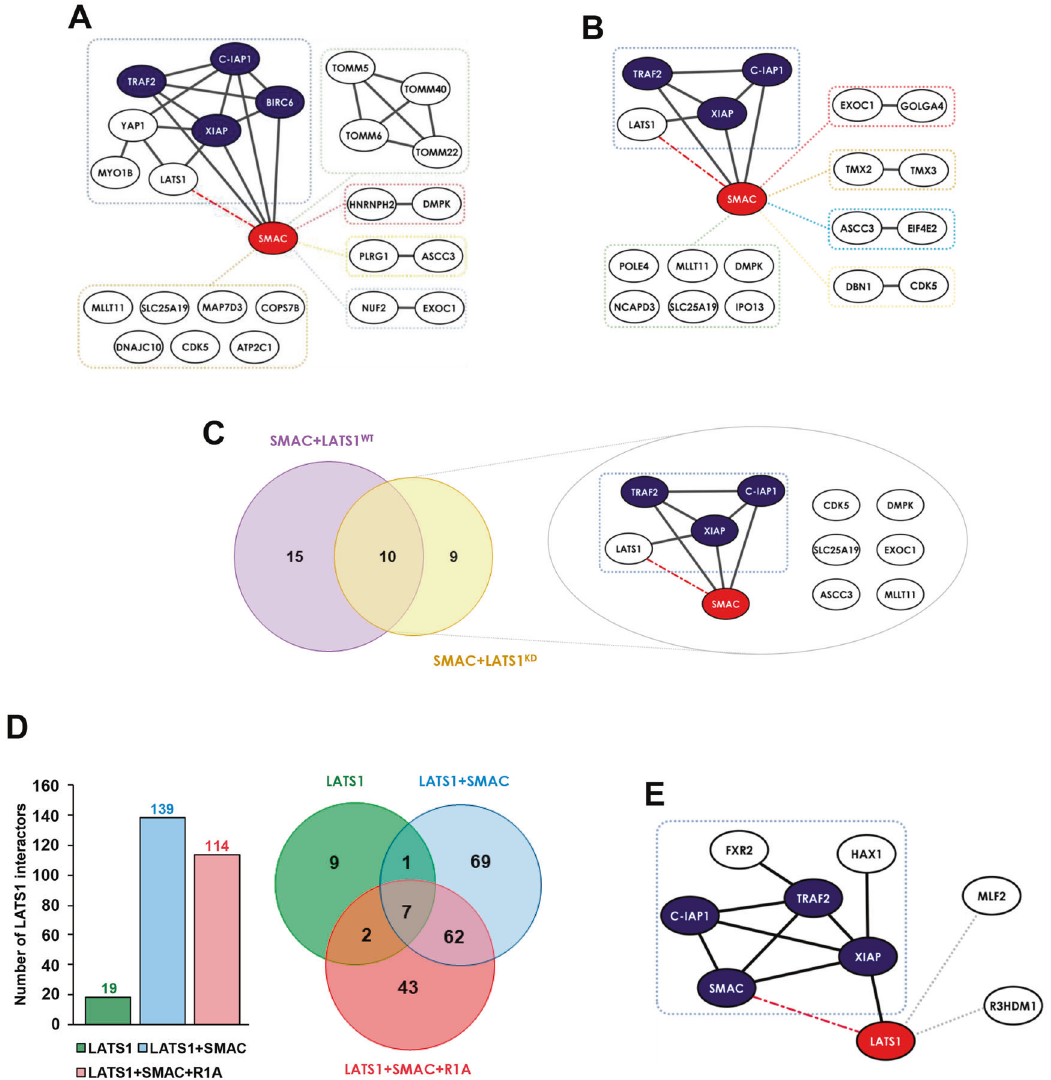
Fig. 4 Pathway reconstruction of SMAC and LATS1 dynamic interactomes. A Visualisation of the GFP-SMAC interactors regulated by FLAG- LATS1 WT in HeLa cells obtained by AP-MS after pathway reconstruction analysis (STRING database). Black edges represent reported interactions. Dash lines represent new interactions. Red node represents the bait (SMAC). Blue nodes represent the selected core components of the LATS1-SMAC complex. B Visualisation of the GFP-SMAC interactors regulated by FLAG-LATS1 KD in HeLa cells obtained by AP-MS after pathway reconstruction analysis (STRING database). Black edges represent reported interactions. Dash lines represent new interactions. Red node represents the bait (SMAC). Blue nodes represent the selected core components of the LATS1-SMAC complex. C Venn diagram representing the SMAC interactors modulated by LATS1 indicating the amount of them shared by FLAG-LATS1 WT and FLAG-LATS1 KD (left panel). Visualisation of the cluster of SMAC interactors regulated by both LATS1 WT and LATS1 KD after pathway reconstruction analysis (STRING database). D Graph representing the number of speci fi c proteins interacting with FLAG-LATS1 after AP-MS in A375 cells expressing either LATS1 alone or in combination with GFP-SMAC or GFP-SMAC and FLAG-RASSF1A as indicated (left panel). Venn diagram representing the number of LATS1 interactors which are either speci fi c or shared among the different conditions (right panel). E Visualisation of the proteins interacting with FLAG-LATS1 differentially regulated by SMAC in A375 cells upon RASSF1A re-expression (i.e. fold ≤ 0.66 or fold ≥ 1.5 of LATS1 + SMAC vs LATS1 + SMAC + RASSF1A). Pathway reconstruction analysis is represented (STRING database). Red node represents the bait (LATS1). Blue nodes represent the selected core components of the LATS1-SMAC complex. Black edges represent reported interactions. Dash lines represent new proapoptotic network, which includes the intrinsic apoptosis expression of RASSF1A, which is commonly reported in this cancer pathway, in addition to the activation of the well-characterised type [39]. We show that the loss of RASSF1A expression likely proliferative pathways such as the ERK and AKT branches [1]. prevents SMAC from inhibiting IAPs, as the LATS1-SMAC complex Finally, we also explored the possible relevance of the novel is not effectively induced in these cells. Importantly, RASSF1A loss molecular mechanisms described here for the treatment of can cause the upregulation of the YAP1 target C-IAP2 further mutant BRAF tumours. Specially interesting was the relevance to showing the relevance of the MST2 pathway in the regulation of the effectiveness of novel SMAC mimetics that are currently being apoptosis through IAP-SMAC [40]. These data, together with our tested in clinical trials [41, 42]. Overexpression of IAPs have been previous fi ndings, draw a picture where oncogenic BRAF- shown in metastatic melanoma and is considered one of the dependent transformation requires the silencing of the MST2